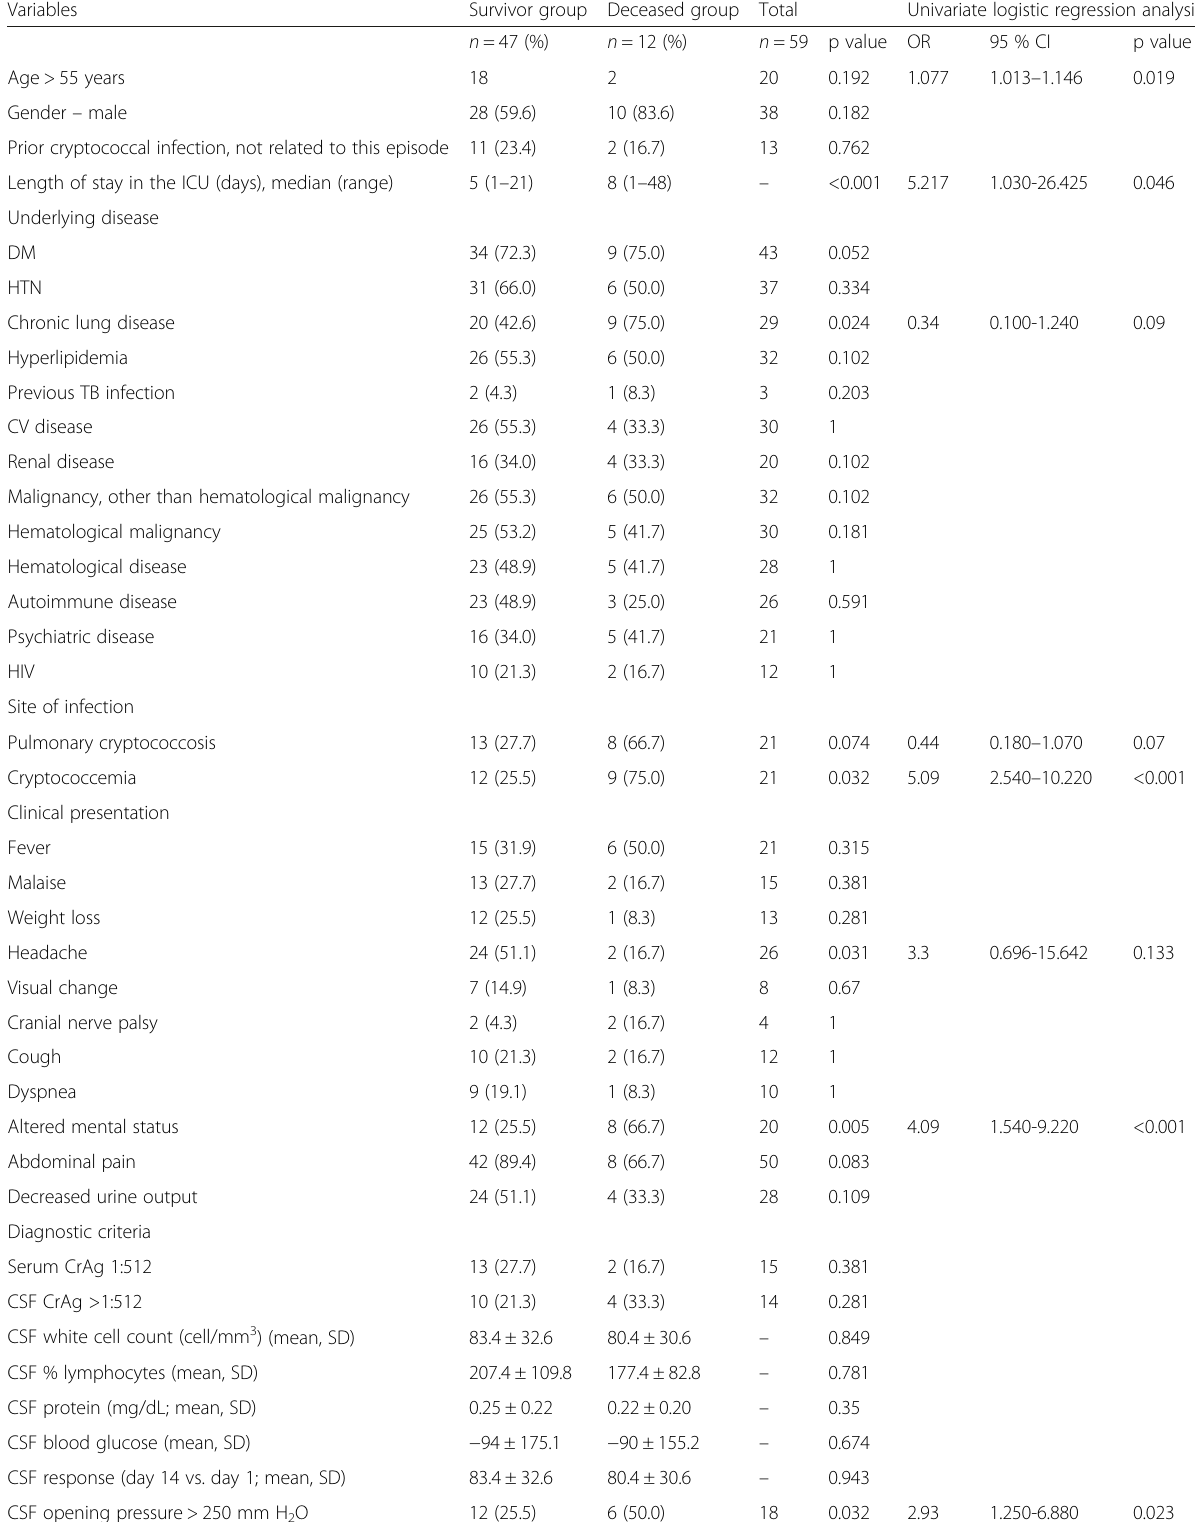
Table 1 Comparison of key variables between the survivor and deceased groups of CM patients